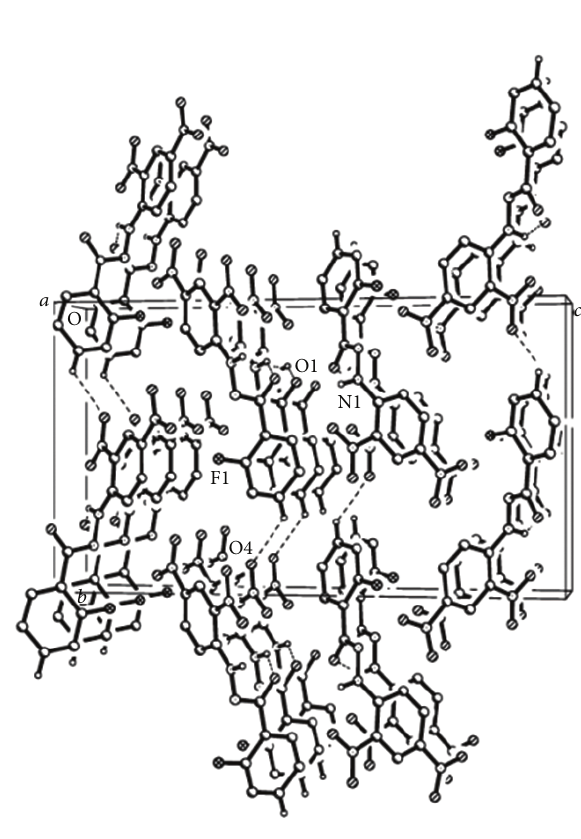
Figure 2: Crystal packing is viewed approximately along a -axis with H-bonding as dashed lines. H atoms not involved are